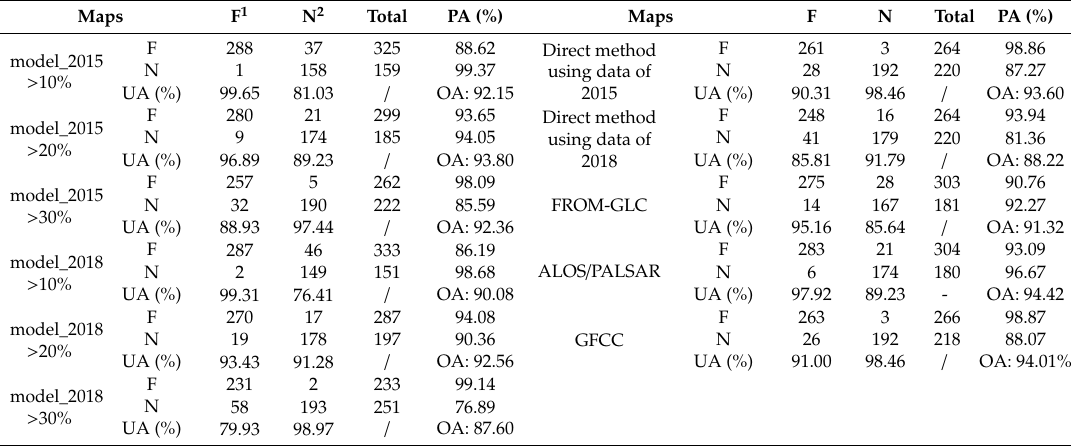
Table 3. Assessment of forest / non-forest maps (484 sampling plots are collected, including 289 forest and 195 non-forest samples plots). OA: overall accuracy, PA: producer accuracy, UA: user